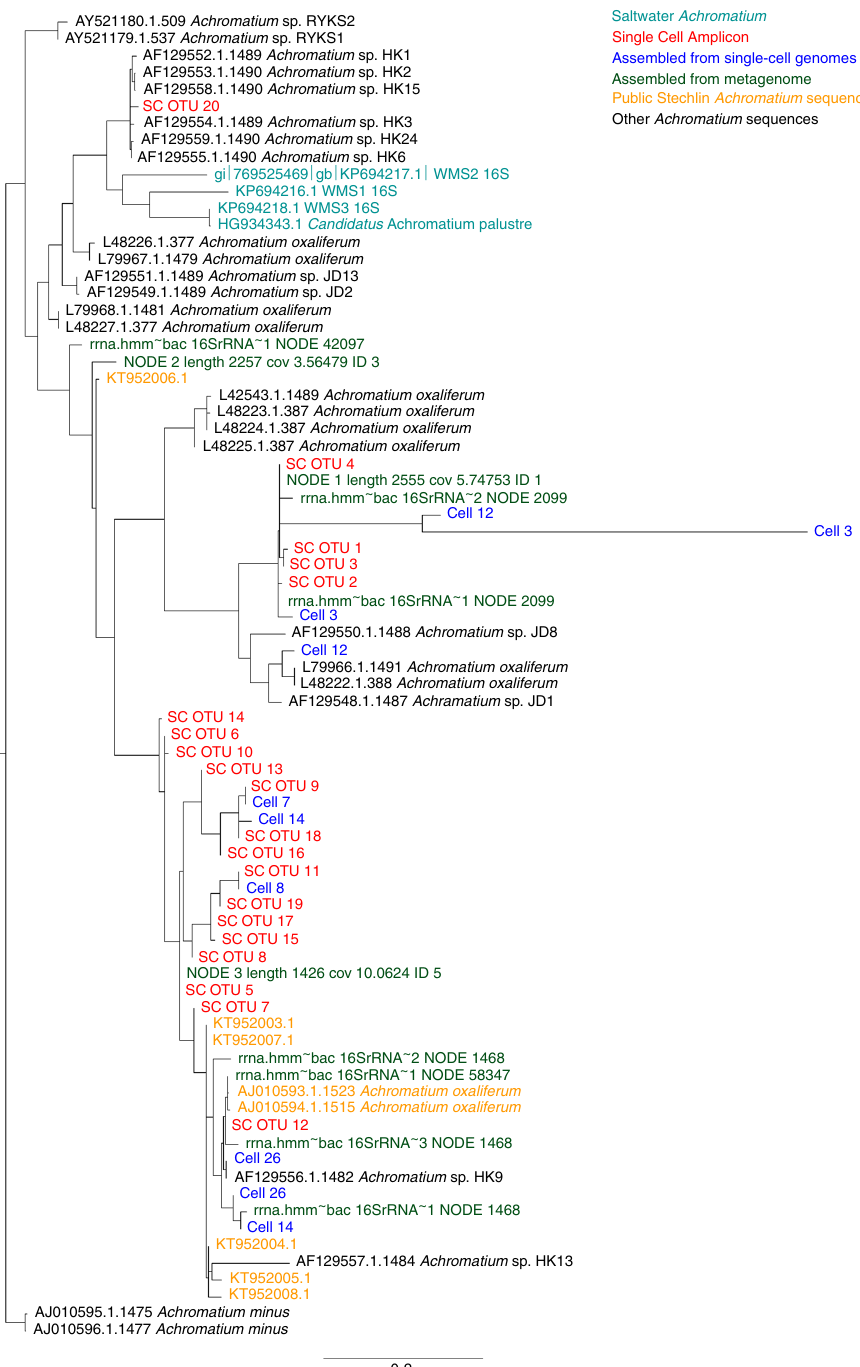
Fig. 2 Maximum likelihood tree of 16S rRNA sequences from Achromatium . The sequences were obtained from single Achromatium cells from Lake Stechlin, metagenomics data of the same cell population, and reference sequences. A similar tree which includes distance-clustered amplicon sequences is given in Supplementary Fig. 2A. A similar tree created using only full-length sequences to which the shorter ones were added by parsimony is provided as Supplementary Fig.